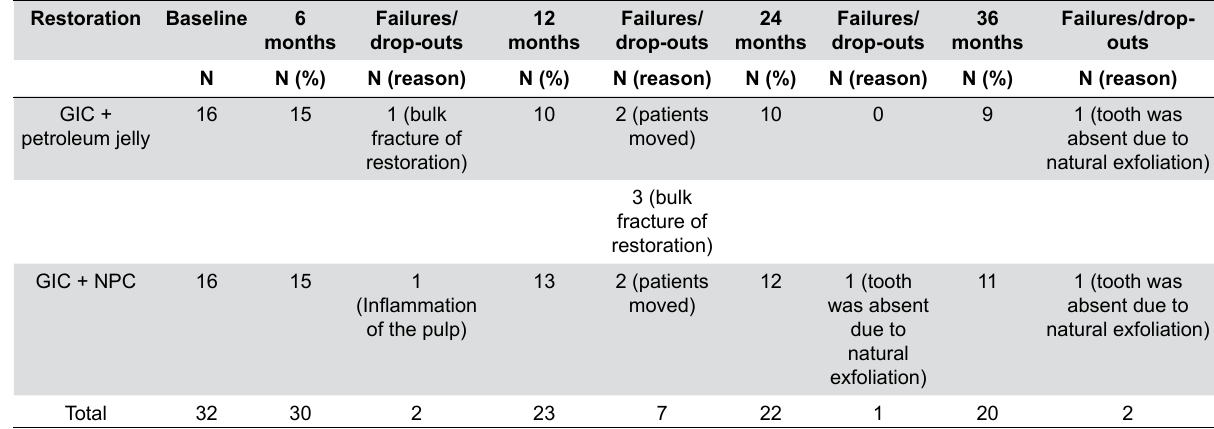
Table 1- Distribution of patients over the clinical trial according to surface protection and reasons for failures/drop-outs